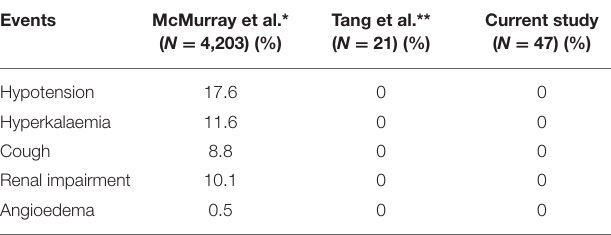
TABLE 3 | Adverse events during sacubitril-valsartan treatment. Events McMurray et al.* Tang et al.** Current study ( N = 4,203) (%) ( N = 21) (%) ( N = 47) (%) Hypotension 17.6 0 0 Hyperkalaemia 11.6 0 0 Cough 8.8 0 0 Renal impairment 10.1 0 0